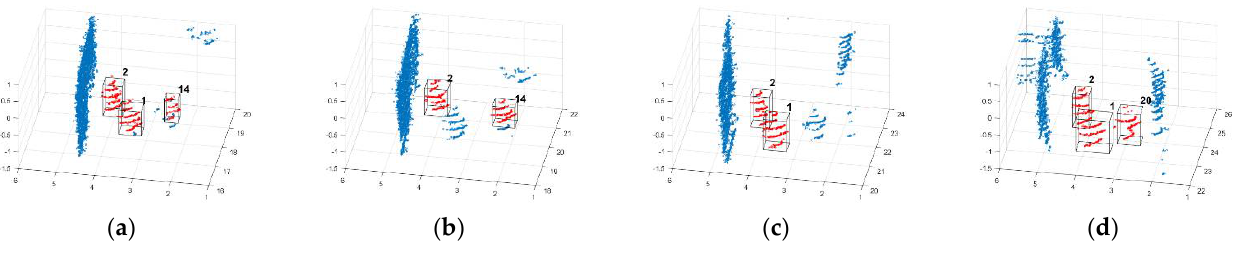
Figure 10. Tracks #0 and #1 in frames 63 ( a ), 70 ( b ), 76 ( c ) and 84 ( d ) in Data Set I (Unit: m).